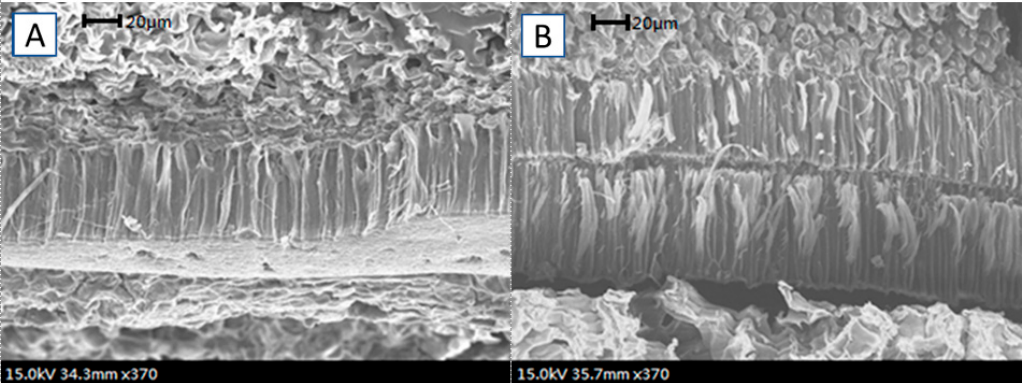
Figure 2. The microstructure of macroesclereids layers of adzuki bean seeds of two varieties: ( A ) Kaohsiung 8 and ( B ) Kaohsiung 10 grain microstructure (SEM, 15 kV, 370 X).